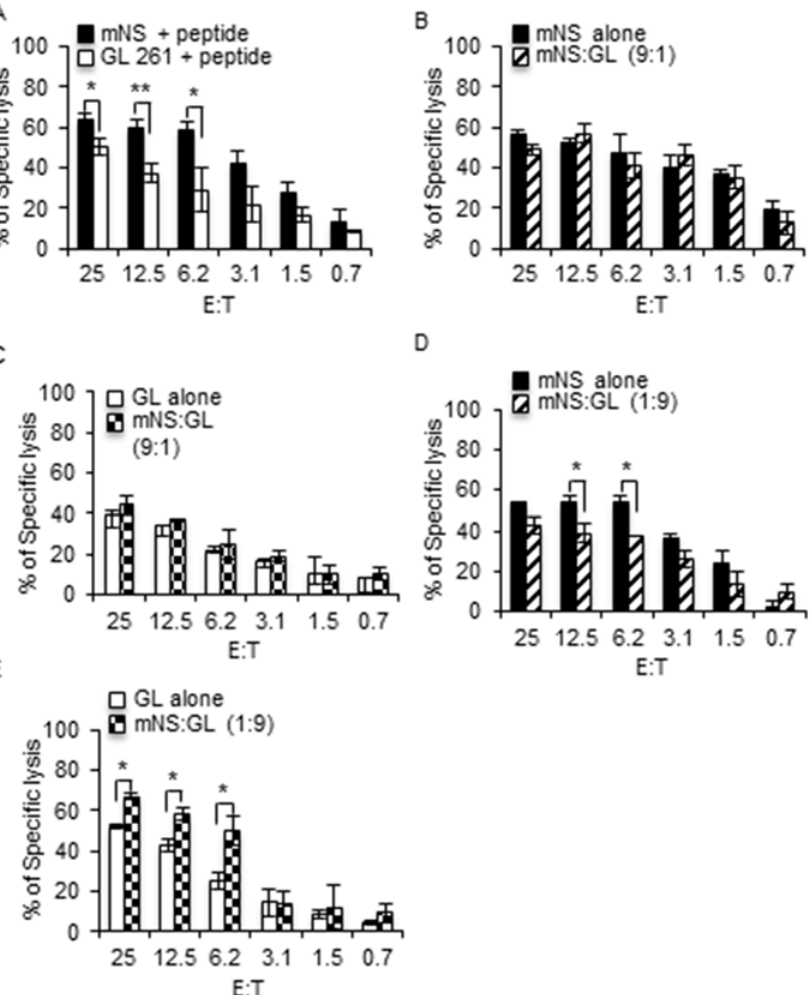
Fig 3. GSC enhance the killing of GDC by day 6 PMEL CTL. (A) GL261 and mNS were loaded with calcein AM and calcein Red Orange respectively, then pulsed with peptide and mixed in 1:1 ratio before simultaneous incubation with day 6 PMEL CTL in a dual color cytotoxicity assay. The cytotoxicity toward each target is followed by measuring the release of the respective calcein in the supernatant. (B) Peptide- pulsed mNS cells alone were used as target for day 6 PMEL CTL in a classical calcein AM release assay (mNS alone), while on the other side peptide-pulsed mNS were mixed in 9:1 ratio with peptide-pulsed